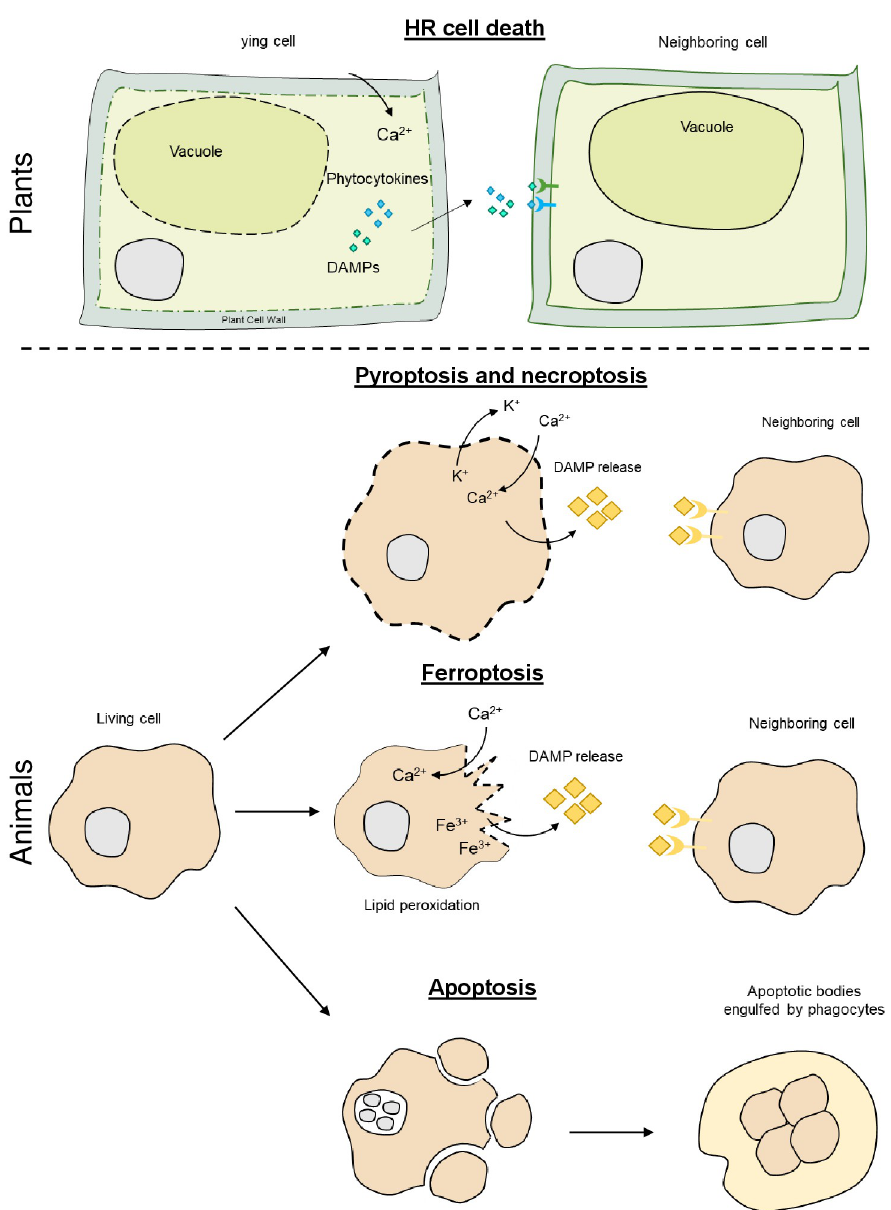
Fig 2. Overview of cell death types and their general features in plants and animals. During HR cell death in plants, ROS accumulation and calcium channel activity exerted by plant resistosomes drive Ca 2+ entry into the cytoplasm. How intracellular Ca 2+ spikes lead to downstream cell death features such as loss of chloroplast and mitochondrial and eventually cellular demise is currently unknown. DAMPs and phytocytokines are released from infected/damaged cells and activate defense responses in neighboring cells via perception by surface receptors. Although differentially regulated at the molecular level, pyroptosis and necroptosis are both pro-inflammatory forms of cell death that involve release of cellular content to the extracellular space (DAMP release and inflammatory cytokines). In both cell death modalities, rupture of the plasma allows for the influx and efflux of ions altering homeostasis in the cell. Ferroptosis is an iron-dependent mode of cell death in which peroxidation of lipids cause plasma membrane damage with partial rupture allowing entry of Ca 2+ ions and release of DAMPs to the extracellular space. Apoptosis is a non-inflammatory and silent form of cell death in which membrane integrity is maintained during cellular dismantling. Cell shrinkage, chromatin condensation, and DNA fragmentation are typical hallmarks of apoptosis. Importantly, plasma membrane blebbing leads to apoptotic bodies that are eventually engulfed and eliminated by phagocytes. DAMP, danger- associated molecular pattern; HR, hypersensitive response; ROS, reactive oxygen species.